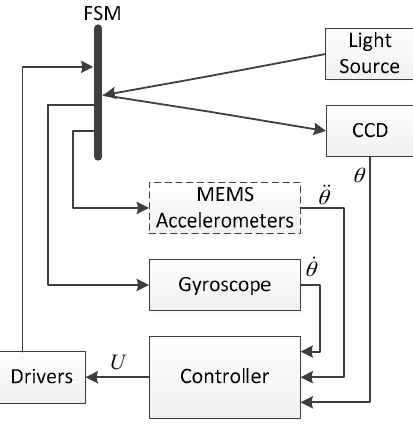
Figure 1. Configuration of the FSM control system.